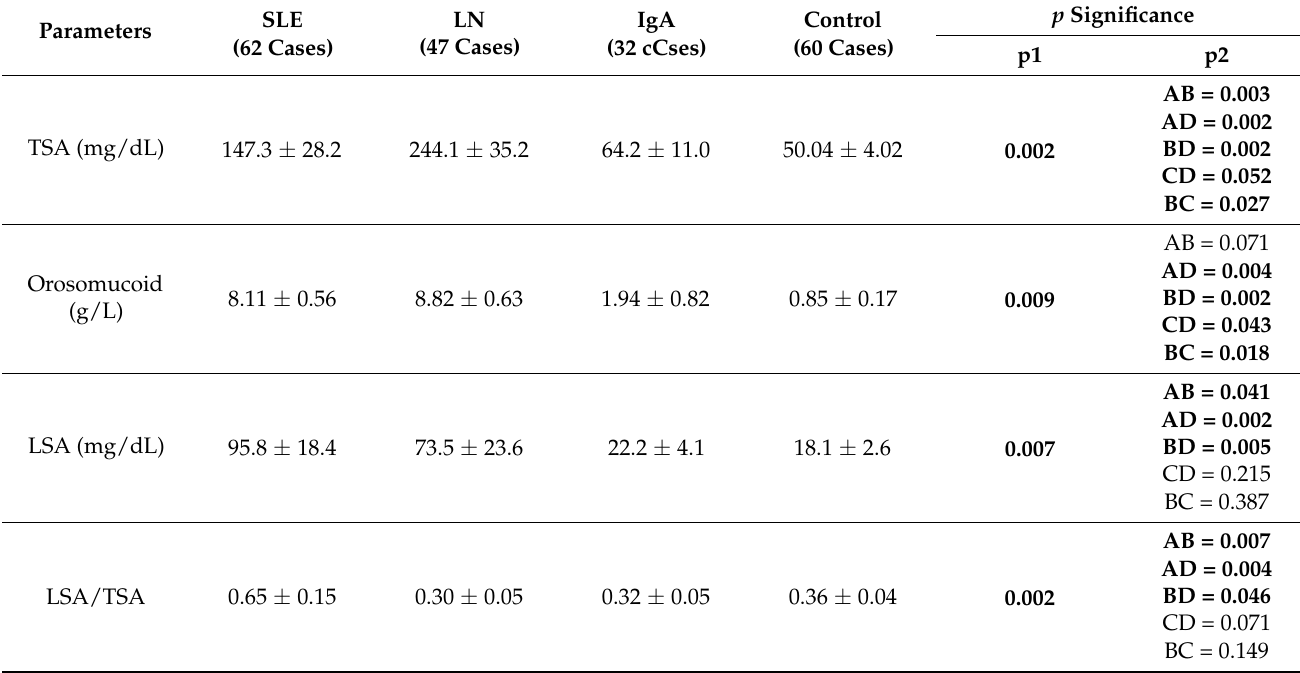
Table 3. Sialylation status in the studied groups.